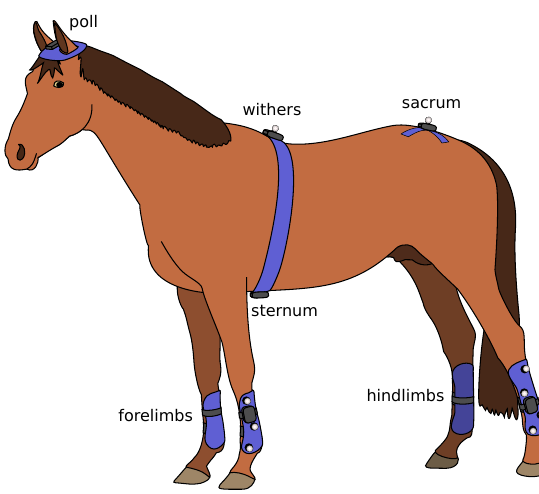
Figure 10. Overview of the equipment attached to each